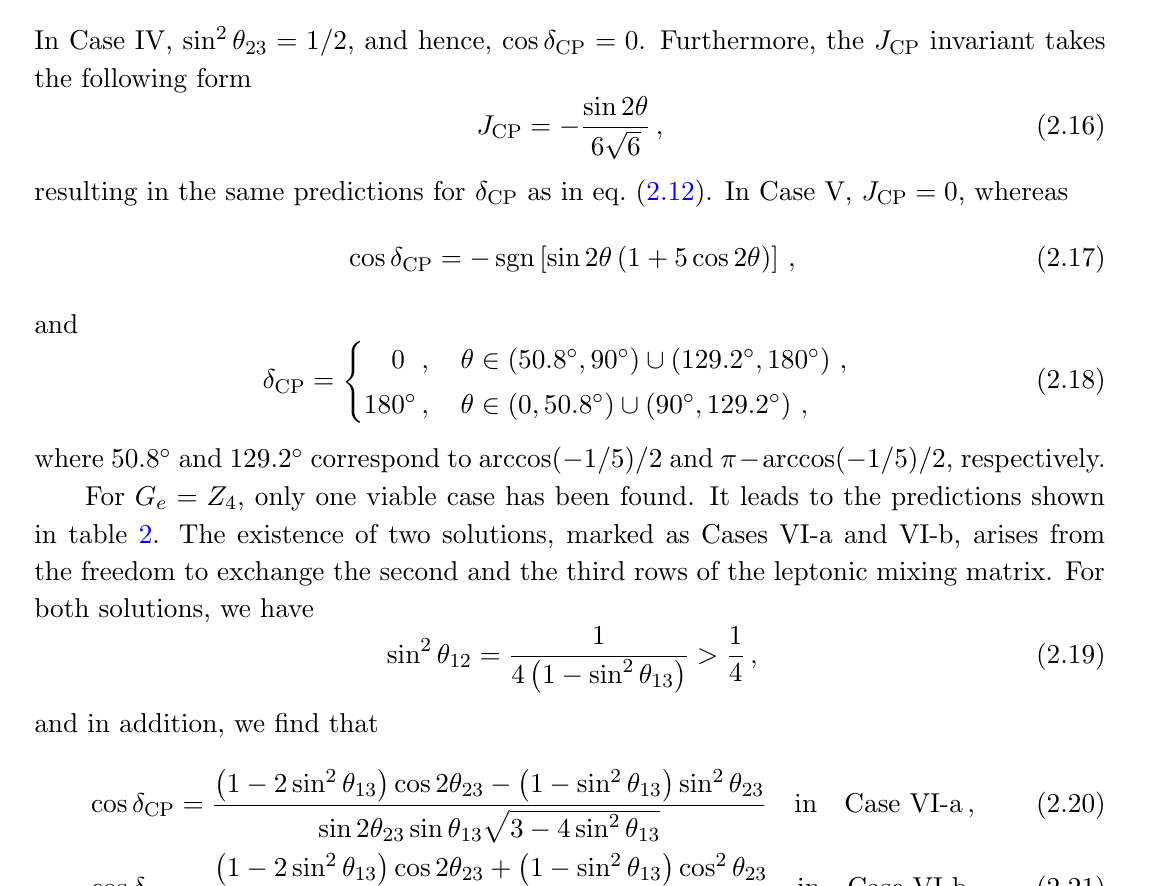
Z 2 ) and G (cid:23) = Z 2 CP derived (cid:2) (cid:2)